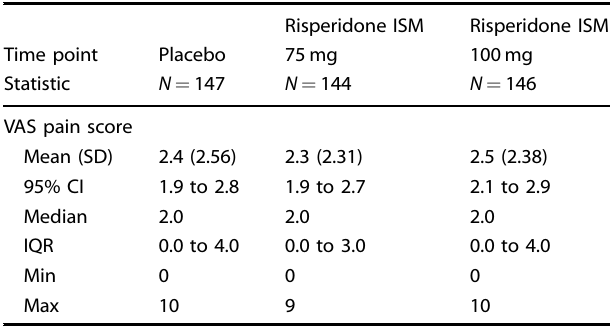
reaction category and maximum VAS